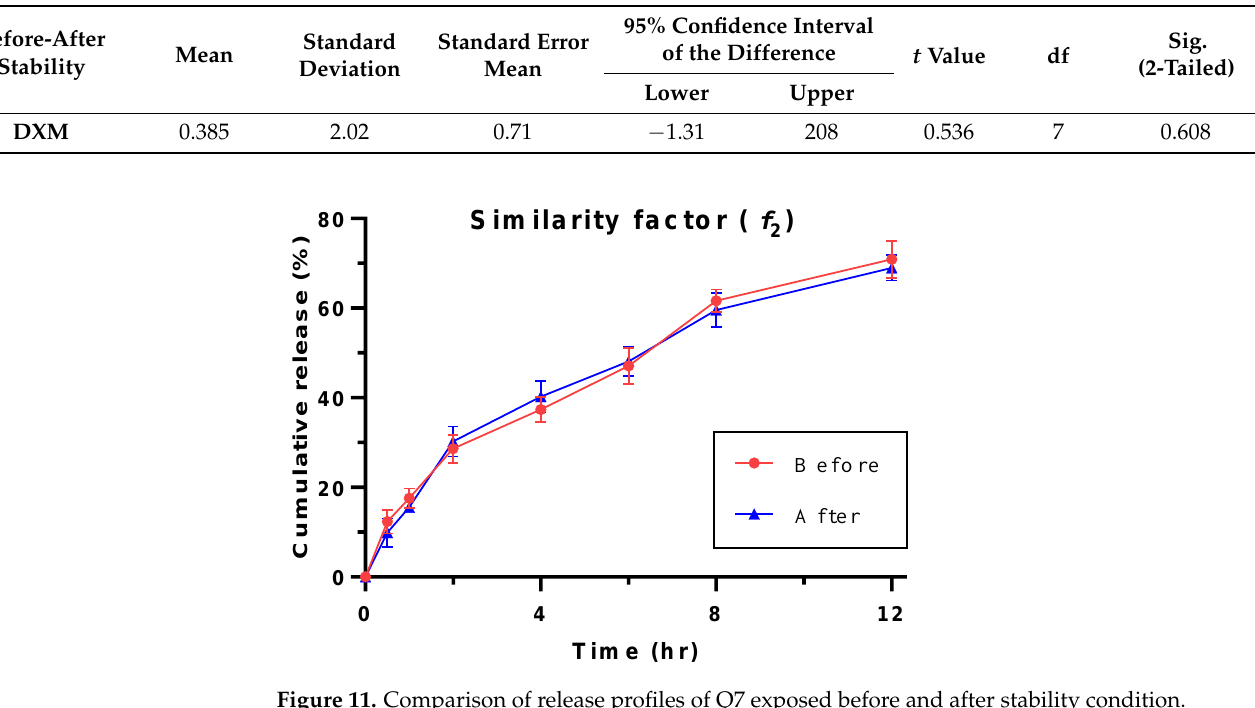
Figure 11. Comparison of release profiles of Q7 exposed before and after stability condition.